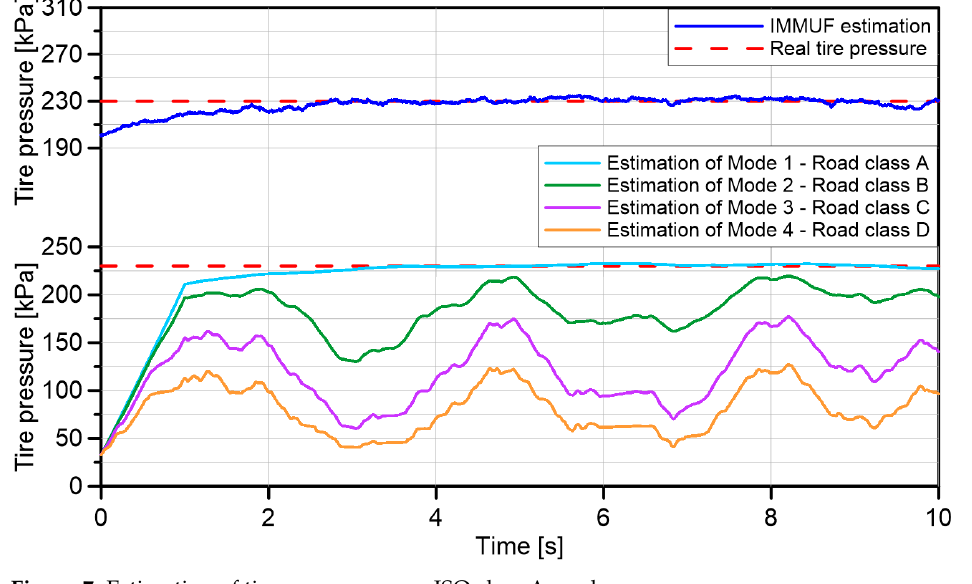
Figure 7. Estimation of tire pressure on an ISO class A road.